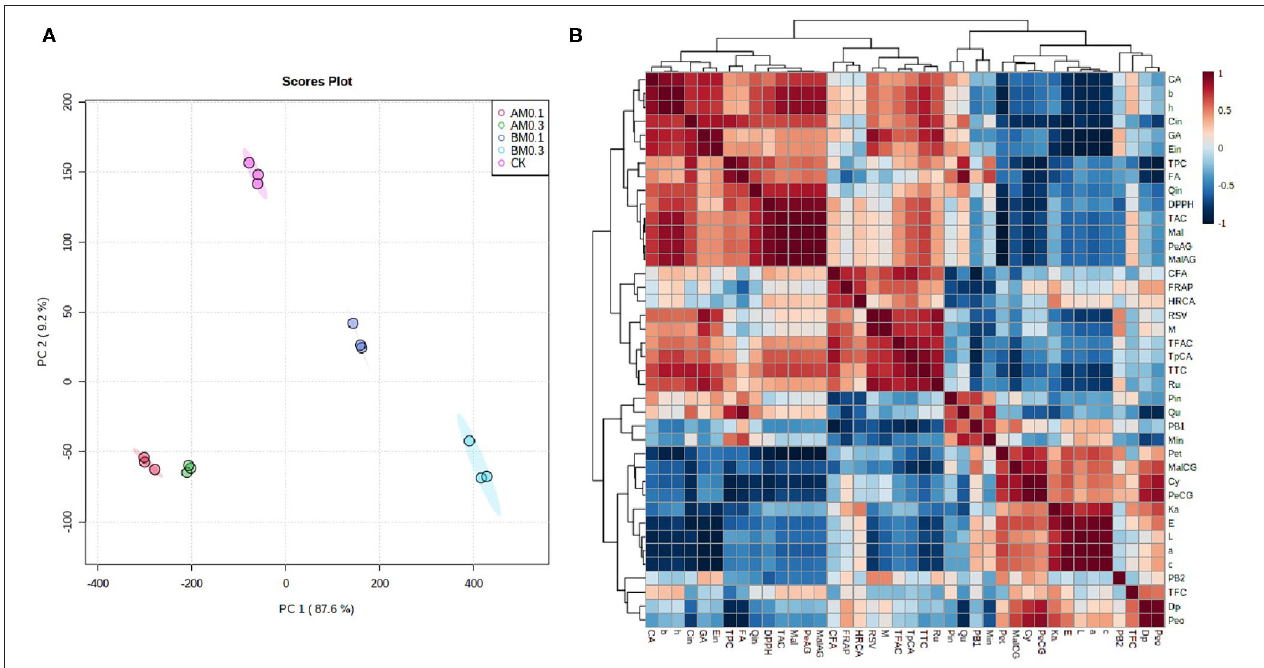
FIGURE 3 | Heat maps of multivariate statistical analysis. (A) Principal components analysis (PCA). CK: control group with 0 g/L MP, BF0.1: 0.1 g/L mannoprotein addition before fermentation, BF0.3: 0.3 g/L mannoprotein addition before fermentation, AF0.1: 0.1 g/L mannoprotein addition after fermentation, BF0.3: 0.3 g/L mannoprotein addition after fermentation. (B) Correlation analysis between phenolics concentrations and color characteristics, antioxidant capacity. Data was normalized by a pooled sample from control